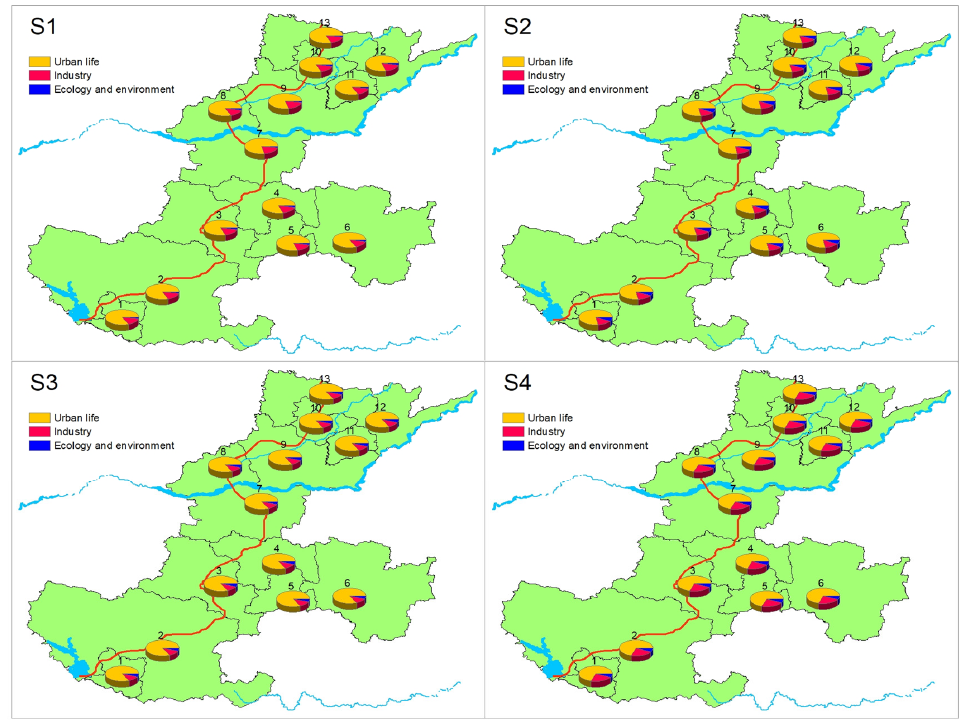
Figure 8. COD emission proportions under different scenarios in different departments (%). Note: S1, Scenario 1; S2, Scenario 2; S3, Scenario 3; S4, Scenario 4; 1, Dengzhou City; 2, Nanyang City; 3, Pingdingshan City; 4, Xuchang City; 5, Luohe City; 6, Zhoukou City; 7, Zhengzhou City; 8, Jiaozuo City; 9, Xinxiang City; 10, Hebi City; 11, Huaxian County; 12, Puyang City; 13, Anyang